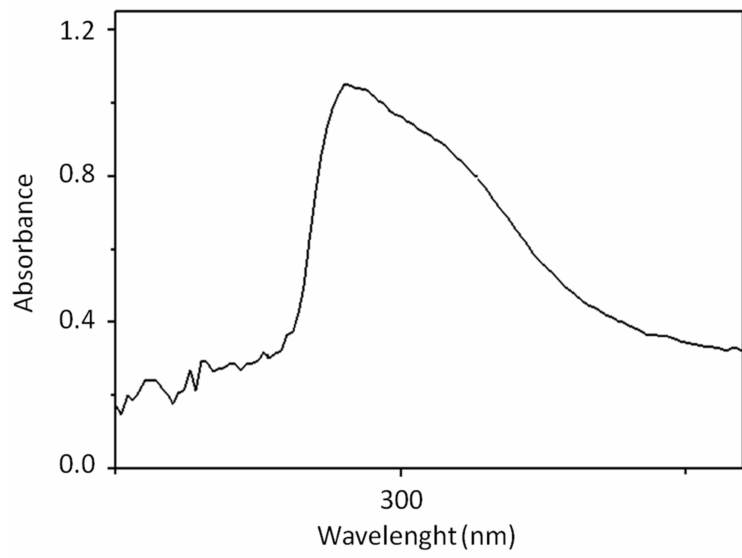
Figure 1. Characteristic UV band of an OVWs